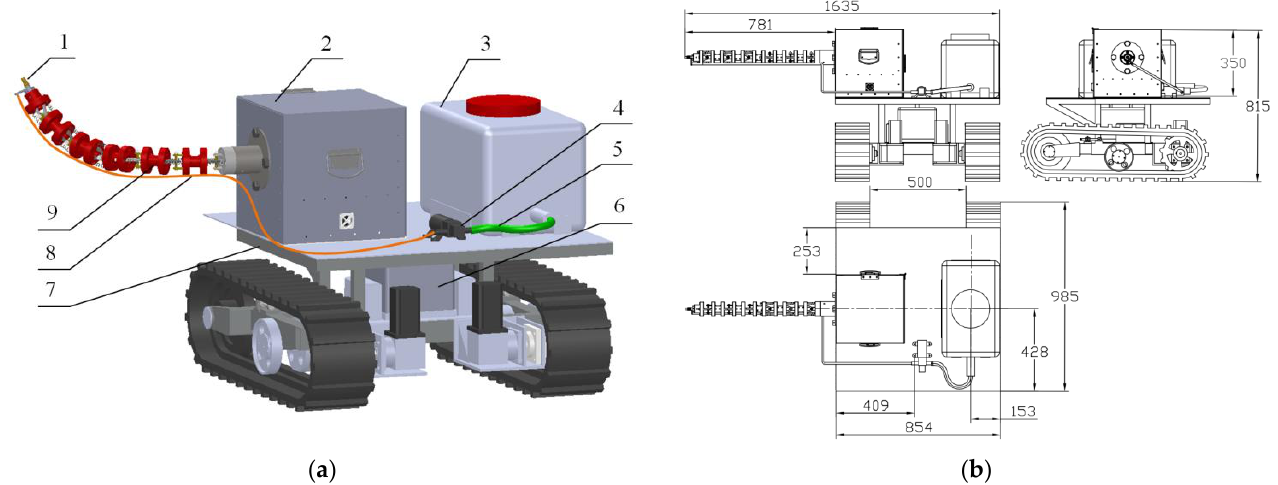
Figure 2. ( a ) The overall model of the CDTSR: (1) nozzle; (2) cable-driven manipulator control box; (3) pesticide box; (4) diaphragm pump; (5) inlet pipe; (6) track vehicle control box; (7) track vehicle; (8) outlet pipe; (9) cable-driven manipulator. ( b ) CAD drawings with different viewing angles of the CDTSR (the unit is mm).